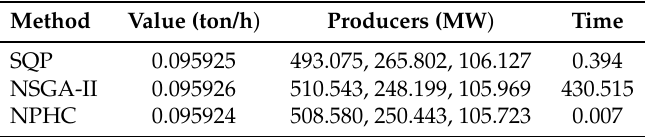
Table 6. Minimization of NO x emissions.